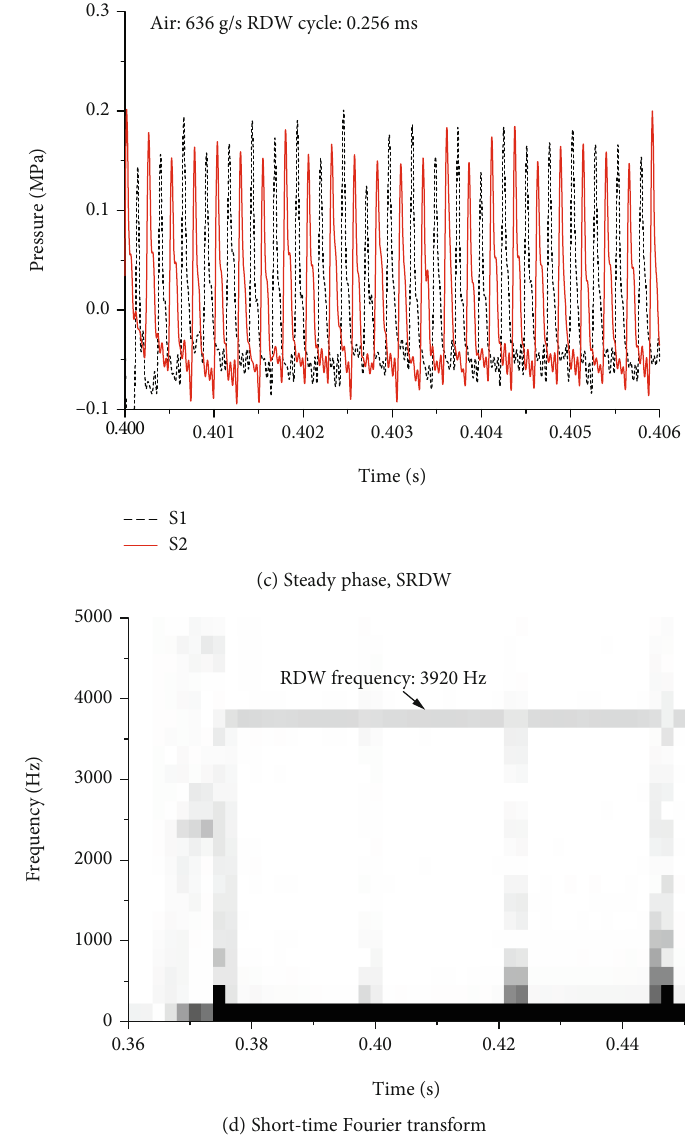
Figure 8: Pressure traces obtained by S1 and S2 for the air mass fl ow rate 636g/s and short-time Fourier transform for the pressure trace